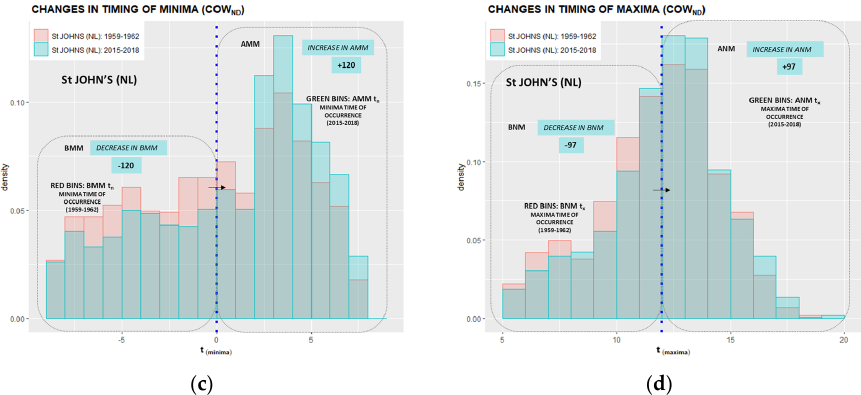
Figure A18. Atlantic Canada climate region: Charlottetown (PE) and St. John’s (NL). Time evolution of the Diurnal Extrema Timing (DET) histograms at Charlottetown ( a , b ), and St John’s ( c , d ) stations. Migration of the Before Midnight Minima (BMM) to After Midnight Minima (AMM) and migration of the Before Noon Maxima (BNM) to After Noon Maxima (ANM) between four-year averages at the beginning (1953–1956) and ending (2015–2018) of data ranges at Charlottetown (PE) and between (1959–1962) and (2015–2018) of data ranges at St. John’s (NL) station. The blue dotted line represents midnight delineation ( left ) and noon delineation ( right ).